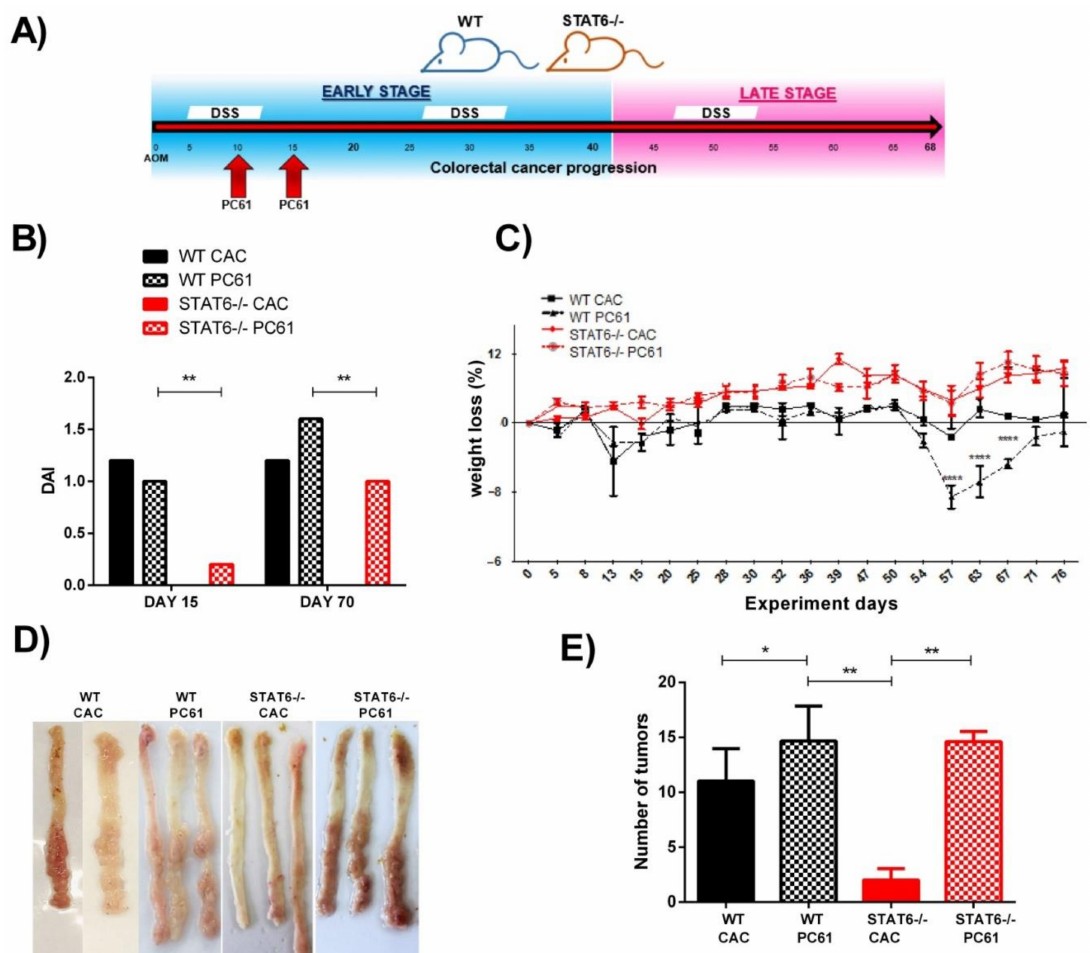
Figure 3. Depletion of Treg cells with anti-CD25 antibody (PC61) during early CAC restores tumor development in STAT6 − / − mice. ( A ) A schematic time schedule of the PC61 antibody administration in the WT and STAT6 − / − mice that received the AOM/DSS administration (CAC-induced mice). After 10 and 15 days, the groups of WT or STAT6 − / − CAC-induced mice were injected i.p. with 200 µ g of PC61 antibody. The CAC progression was analyzed over 77 days. ( B – E ) The disease activity index (DAI) ( B ), body weight loss ( C ), representative photographs of colons opened longitudinally, showing macroscopic aspects ( D ), and number of tumors ( E ) on Day 77, after the AOM/DSS administration in the WT CAC, WT PC61, STAT6 − / − CAC, and STAT6 − / − PC61 mice, are shown. The data are expressed as the mean ± SEM and are representative of two independent experiments, with at least five mice per group. * p < 0.05, ** p < 0.01, **** p <